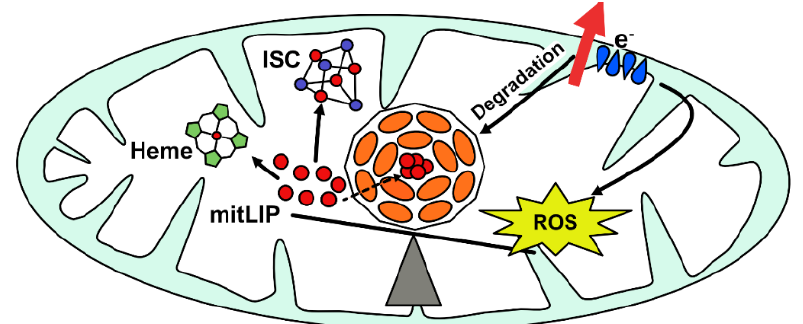
Figure 2. Scheme of the functional role of mitochondrial ferritin. Mitochondrial ferritin (FtMt) bal- ances the amount of redox-active iron (mitLIP), necessary for the maintenance of Iron-Sulphur Cluster (ISC) and heme synthesis and the detrimental development of the ROS. Its greed for incorporating iron is counterbalanced by respiratory chain (e − ) activity, which would appear to be involved in regulating FtMt degradation. In physiological conditions, FtMt expression is detectable only in cells characterized by intense respiratory activity, while in pathological conditions, it is associated with iron overloads in the mitochondrion and iron deprivation in the